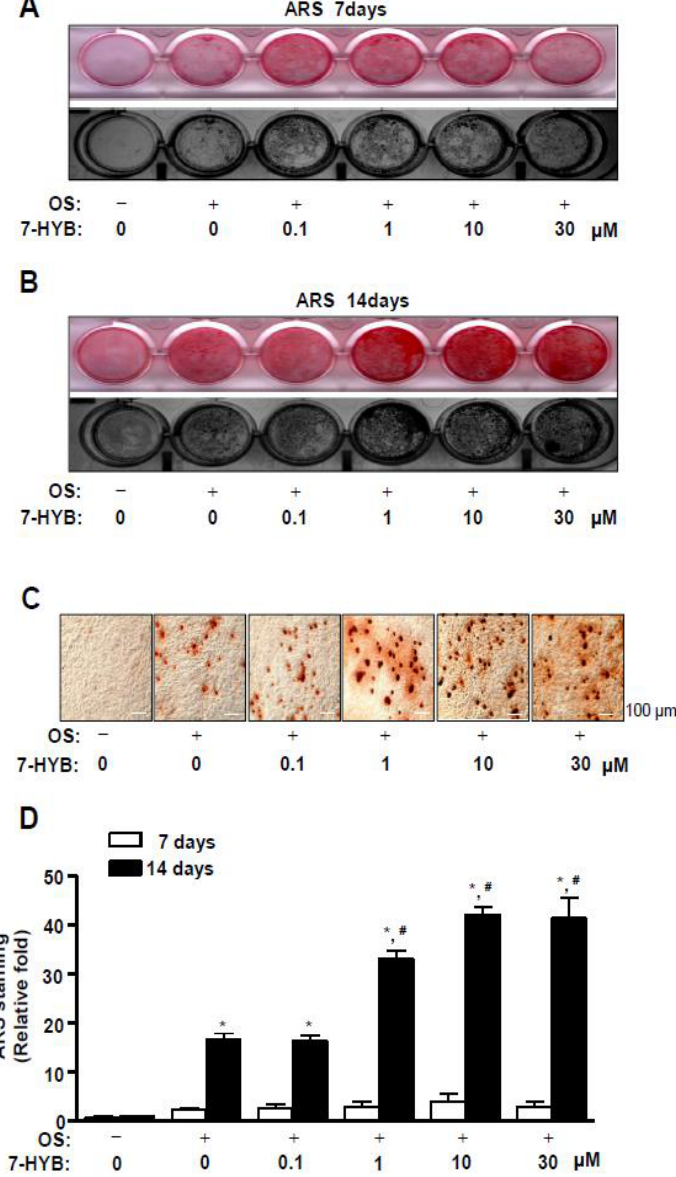
Figure 3. Effect of 7-HYB on the late osteoblast differentiation. ( A–D ) Preosteoblasts were cultured in OS with 0.1, 1, 10, and 30 μM of 7-HYB, and mineralized nodule formation was assessed by ARS staining at seven days ( A ) and 14 days ( B ). The staining of ARS was detected using a scanner ( top ) and colorimetric detector ( bottom ). Mineralization nodules were visualized using a light microscope ( C ). The intensity of mineralized nodule formation was quantified by eluting ARS stains with DMSO, and measured by the Multiskan GO microplate spectrophotometer ( D ). Data represent the mean ± S.E.M. of experiments. *, p < 0.05: statistically significant di ff erence when compared to the control. #, p < 0.05: statistically significant di ff erence when compared to OS.